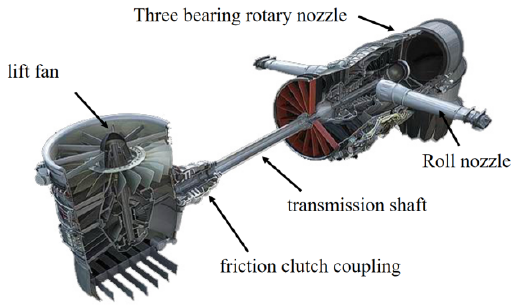
Figure 1. Schematic diagram of the short-range/vertical take-off and landing aircraft propulsion system.